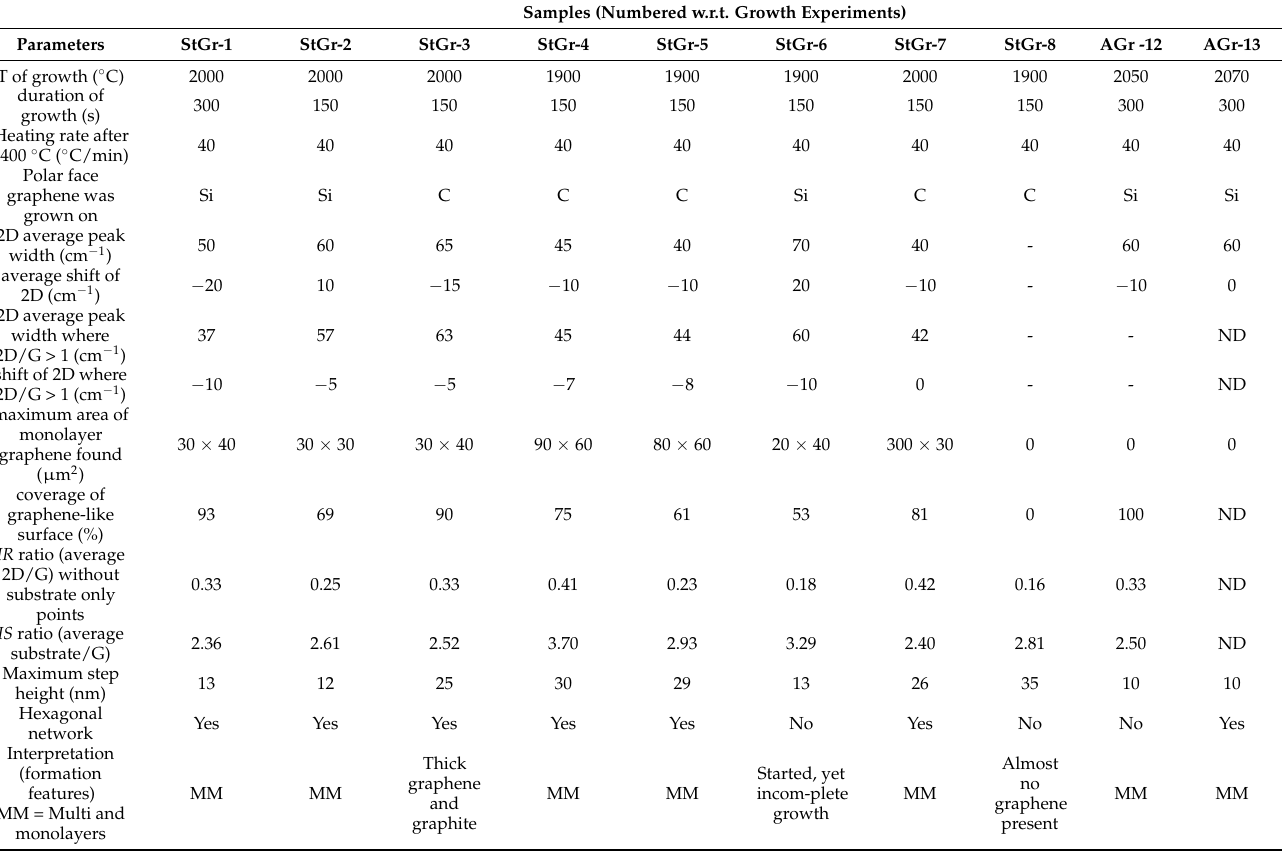
Table 1. List of all the samples, showing the information about the basic growth parameters as well as the most important results. The abbreviation ND means that there are no data available. For the samples where numbers are replaced by lines, there was either no signal detected or the condition 2D > G was